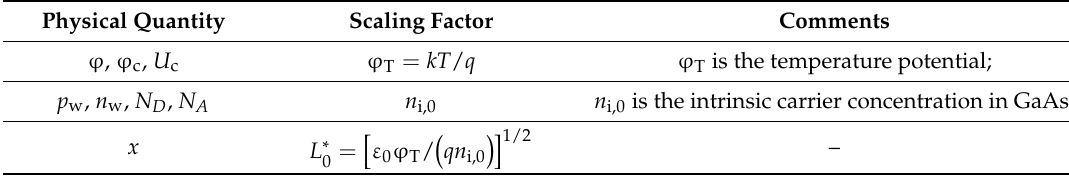
Table 2. The second system of scaling factors for Equations (5) and